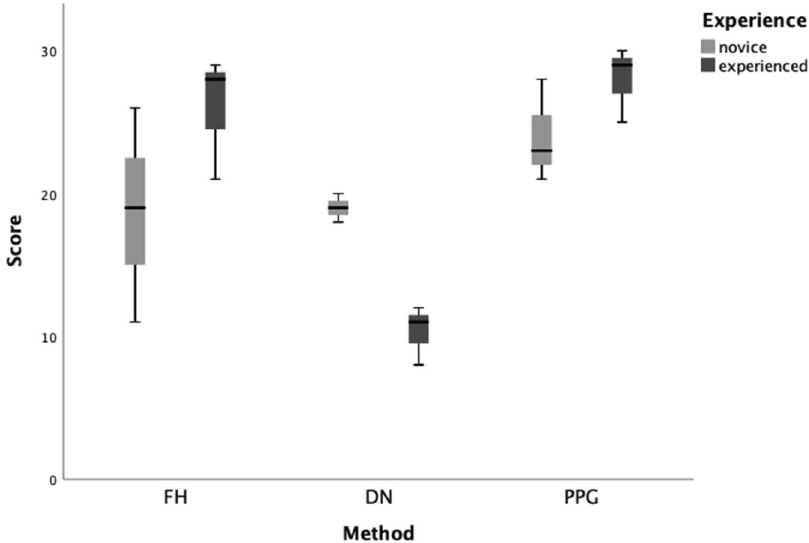
Figure 5. Median and inter-quartile range of the scoring of self-confidence assessment achieved with each method categorized by experience. Boxes comprise of 25th and 75th quartiles and median values, upper and lower whisker indicate highest and lowest values. FH freehand, PPG pilot drill based partial guidance, DN dynamic navigation.